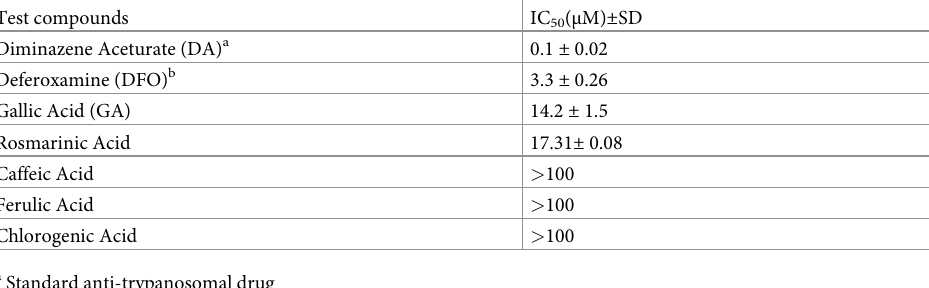
Table 2. Anti-trypanosomal activity of compounds on Trypanosoma brucei brucei . Test